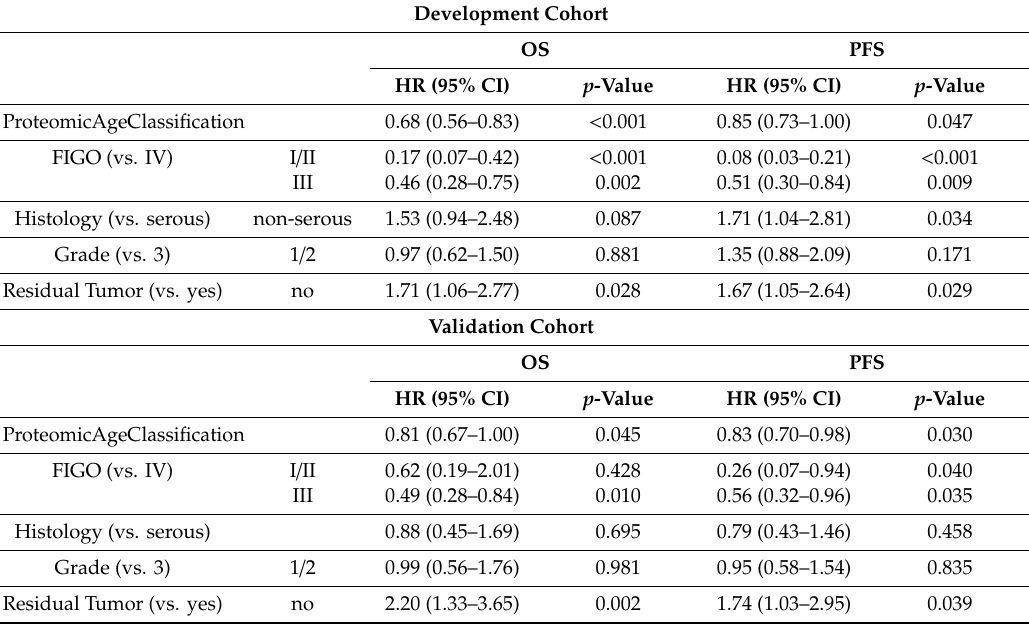
Table 3. Multivariate analysis, using the compound age / test classification attribute for the DC and the